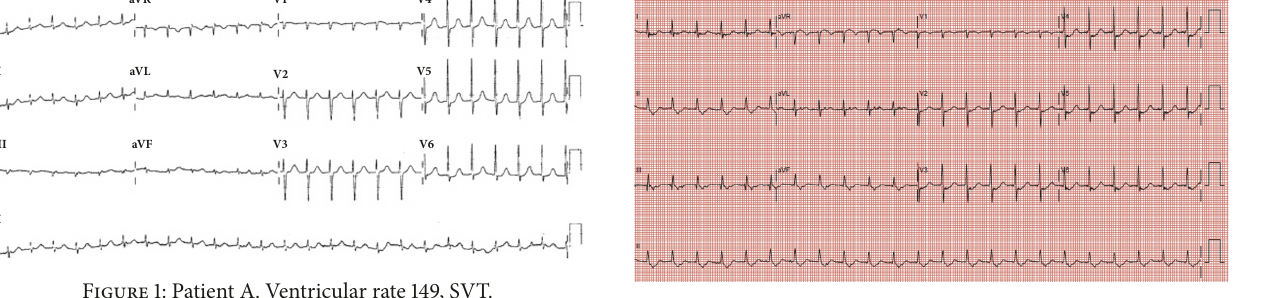
Figure 3: Patient B. 12-lead ECG, ventricular rate 138, and